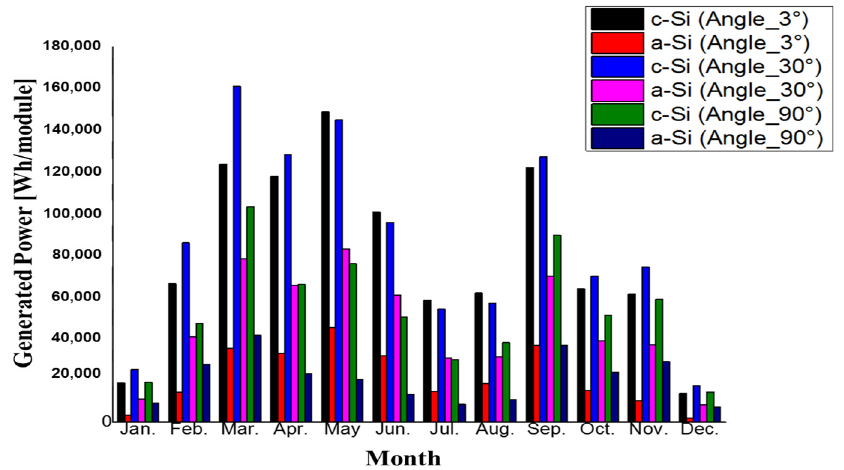
Figure 13. Monthly cumulative power generation for di ff erent installation angles (3 ◦ , 30 ◦ , and 90 ◦ ).